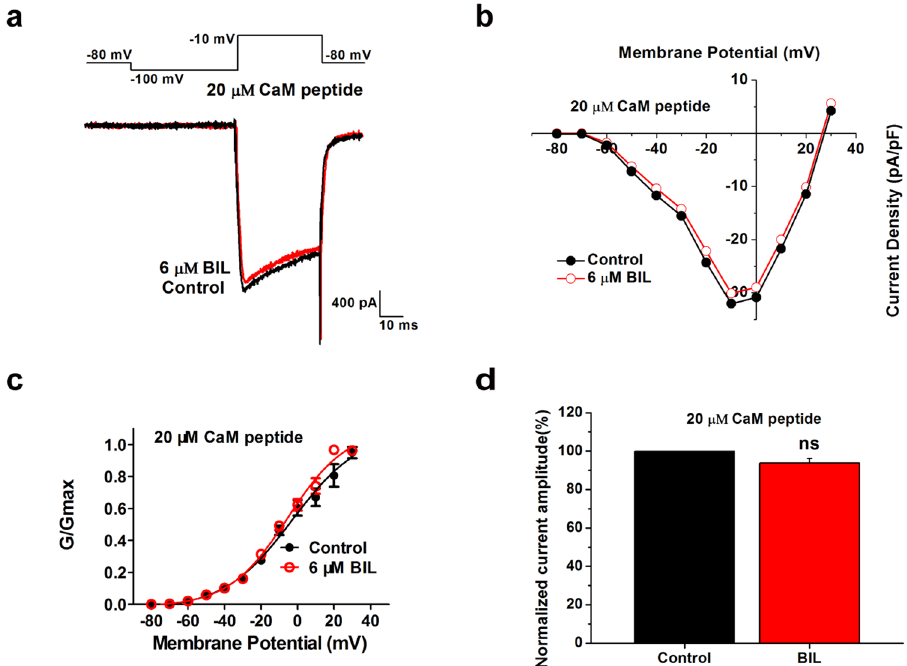
Figure 7. Calmodulin inhibitory peptide affects the amplitude of calcium currents and steady-state activation induced by bilirubin ( a ) Representative traces in control condition (black trace) and bath application of 6 μ M bilirubin (red trace) with 20 μ m CaM inhibitory peptide. Each current was elicited by a 40 ms test pulse to − 10 mV from − 100 mV. ( b ) Current-voltage relationships from data in A measured at the peak current density showed VGCCs currents in control solution (black trace) and 6 µ M bilirubin (red trace). ( c ) Mean conductance- voltage relationships for peak calcium currents from data in A were obtained by a 1 s prepulse to various potentials (10 mV increments) followed by a 50 ms test pulse to − 10 mV are shown. Steady-state activation of VGCCs in control (black circles) and bilirubin group (red circles) were fit to a Boltzmann relationship. Exposure of bushy neurons to 6 μ M bilirubin caused no significantly effect on the steady-state activation curve. ( d ) The normalized VGCC current amplitude before (black bar) and during application of 6 μ M bilirubin (red bar) from nine neurons. There was a smaller current in amplitude with application of bilirubin with CaM inhibitory peptide. ns, not significant, Student’s paired t